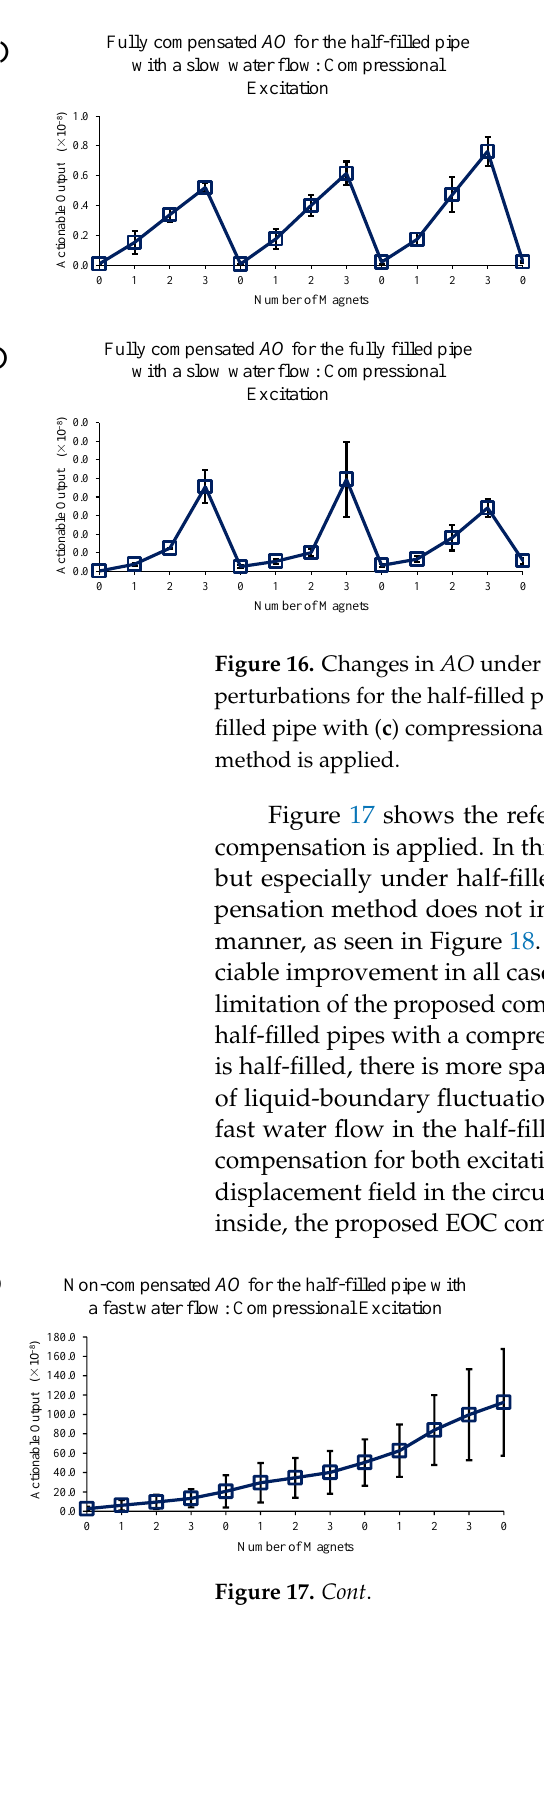
Figure 17. Changes in AO under fast water-flow conditions with the different number of magnet perturbations for the half-filled pipe with ( a ) compressional and ( b ) shear excitations; and the fully filled pipe with ( c ) compressional and ( d ) shear excitations. No EOC compensation method is applied. Figure 18. Changes in AO under fast water-flow conditions with the different number of magnet perturbations for the half-filled pipe with ( a ) compressional and ( b ) shear excitations; and the fully filled pipe with ( c ) compressional and ( d ) shear excitations. Only the 1st EOC compensation method is applied.